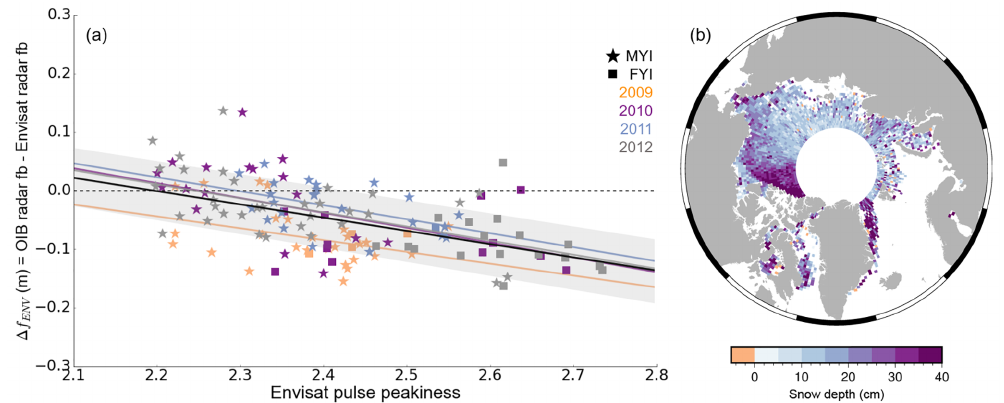
Figure 9. (a) Envisat calibration relationship, derived from comparison of coincident OIB and Envisat data. Data and corresponding linear regression fits for 2009, 2010, 2011, and 2012 are shown in orange, purple, blue, and grey respectively. Star and square symbols represent multi-year and seasonal ice respectively, and the horizontal grey dashed line shows zero. (b) Snow depth for ICESat’s 3E laser period (22 February–27 March 2006), retrieved by subtracting the calibrated Envisat freeboard from the ICESat freeboard and multiplying by a factor of 0.781. Please note that fb is